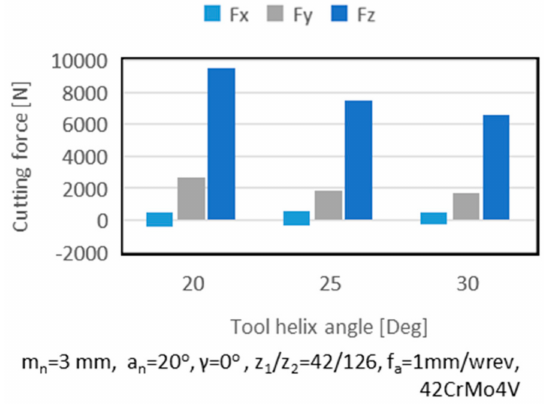
Figure 9. Effect of tool helix angle on cutting forces.